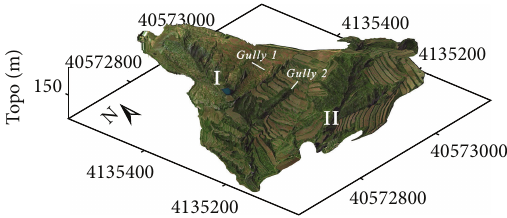
Figure 5: The DOM aerial imagery (red, green, and blue) overlaid on the DEM raster